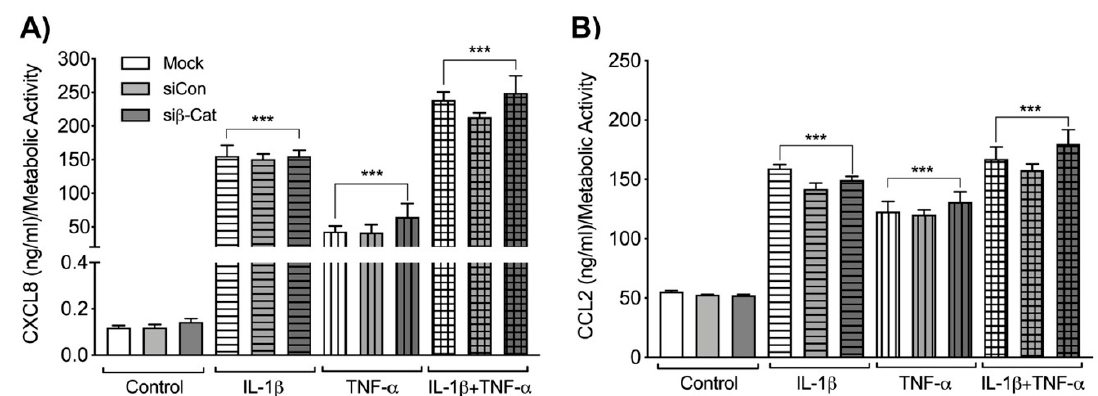
Figure 4. CXCL8 and CCL2 levels following β -catenin knockdown in IL-1 β and TNF- α -activated human astrocytes. Astrocytes were transfected with either no siRNA (Mock, white bars), non-targeting siRNA (siCon, light grey bars) or siRNA specific for β -catenin (si β -cat, dark grey bars). Transfected astrocytes were treated with the HIV-associated cytokines, IL-1 β (20 ng / mL, horizontal pattern) and TNF- α (50 ng / mL, vertical pattern), alone or in combination (graph check pattern). Cell culture supernatants were collected 24 h post treatment. ( A ) C-X-C motif chemokine ligand 8 (CXCL8) and ( B ) C-C motif chemokine ligand 2 (CCL2) protein levels were measured by ELISA and normalized to metabolic activity. Data are representative of three individual astrocyte donors. Statistical analyses were performed using one-way ANOVA with Tukey’s post-hoc test for multiple comparisons (*** p < 0.001 when the bars were compared to their respective untreated controls).